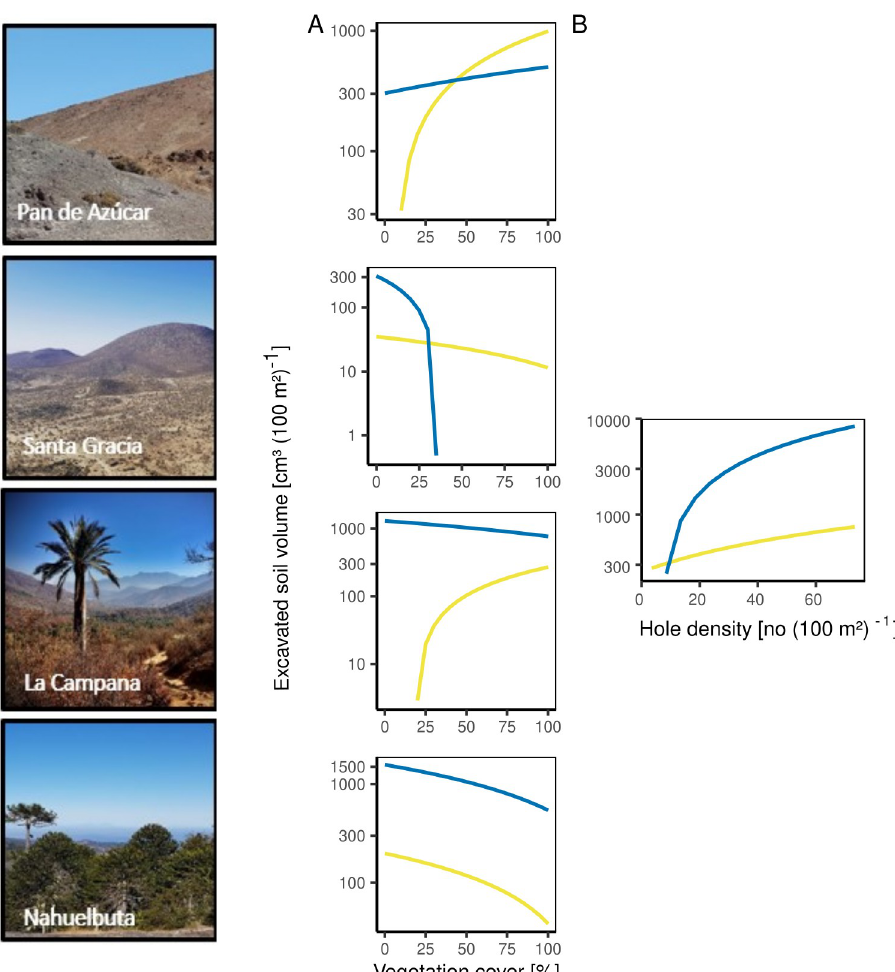
Fig 4. Fitted relation between excavated soil volume (log 10 -transformed) and fixed effects for invertebrates (yellow) and vertebrates (blue) at each site (Pan de Azu´car, Santa Gracia, La Campana, Nahuelbuta). (A) Vegetation cover [%], (B) hole density (log 10 -transformed). Data from both field campaigns were used.